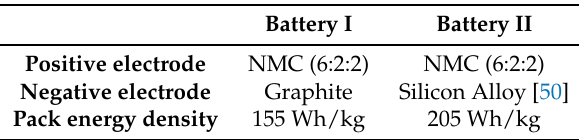
Table 5. Overview of the cell chemistries used for cost calculations. The first one will be referred to as the NMC battery and the second one as the silicon based lithium-ion battery.